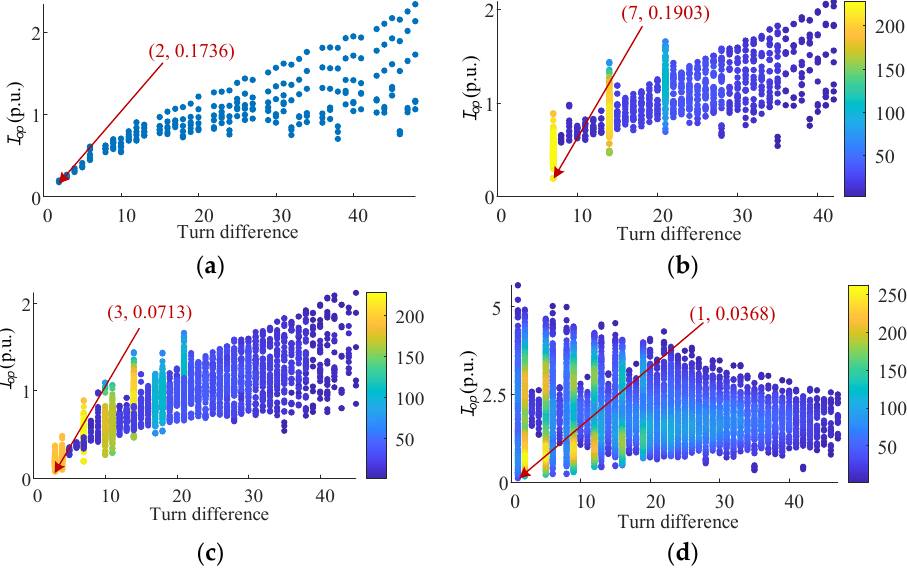
Figure 13. When s = 0.01, the simulation results of all possible internal short ‐ circuit faults in rotor windings: ( a ) in ‐ slot faults; ( b ) end faults in the same branch with different short turns; ( c ) end faults between two branches in the same phase; ( d ) end faults between phases. Table 6. The number of faults whose action value is greater than 0.1